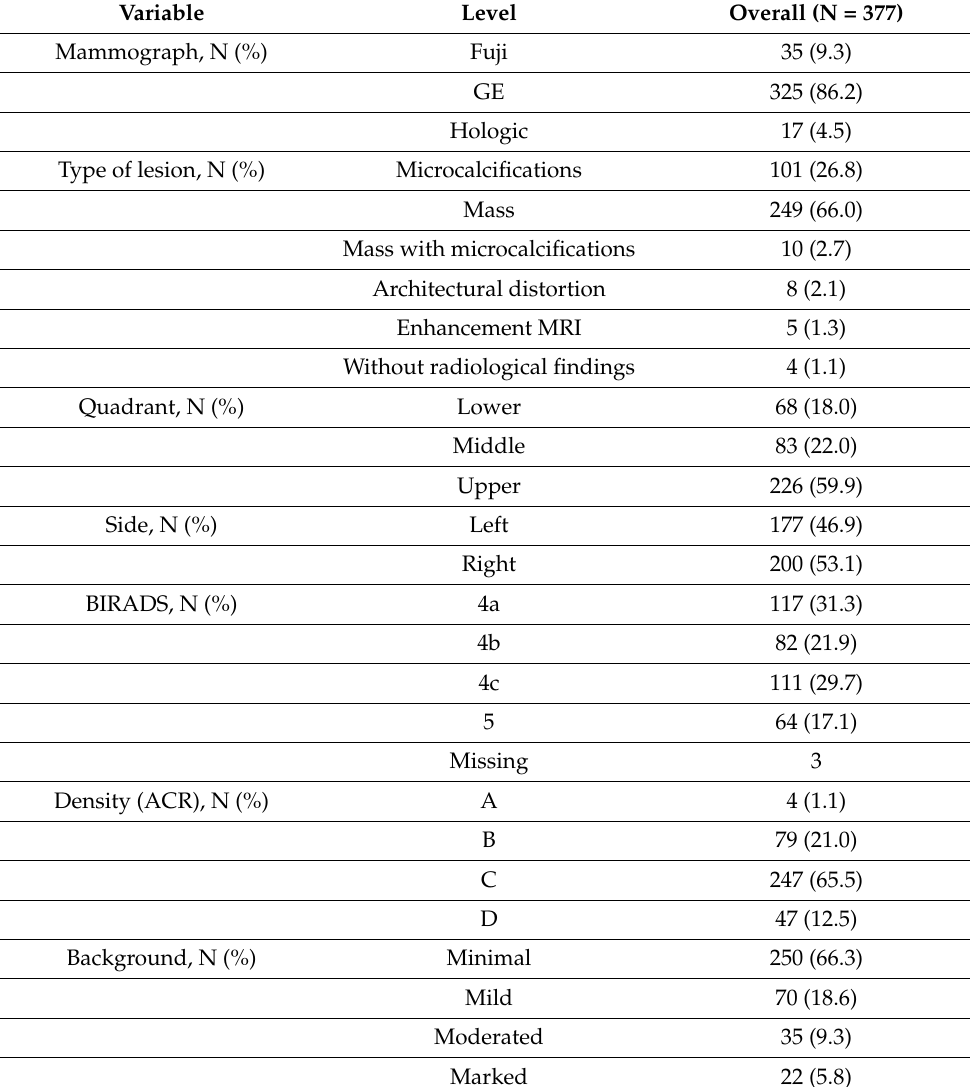
Table 1. Descriptive variables (N =